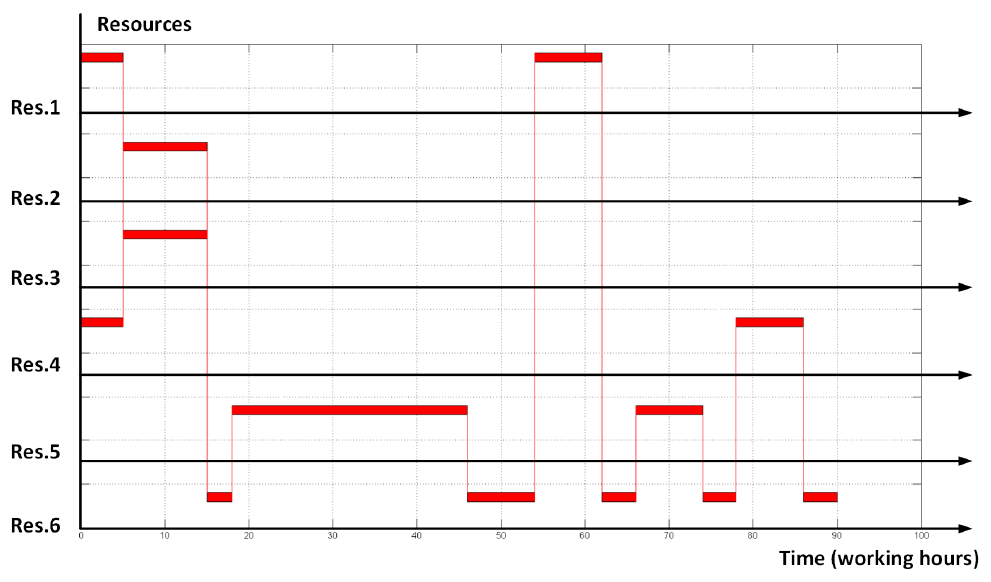
Figure 5. Gannt diagram for single order manufacturing procedure.